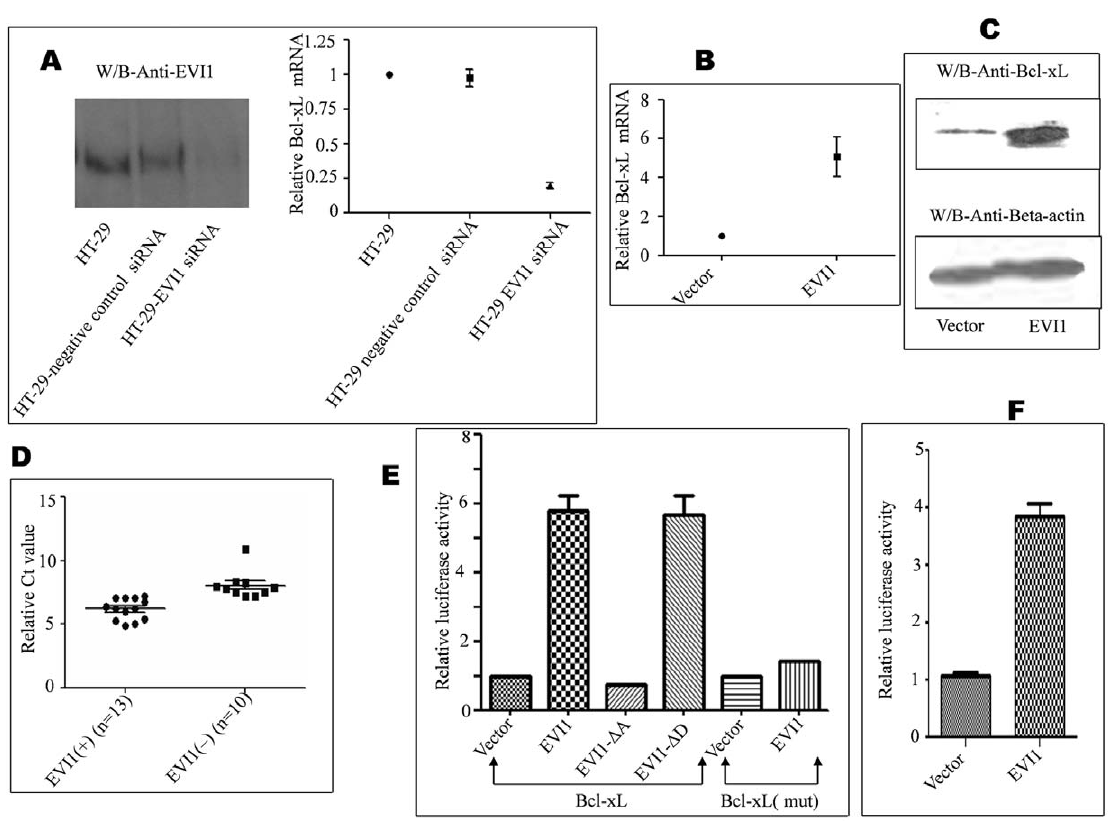
Figure 2. EVI1 induces Bcl-xL promoter trans-activity. A. HT-29 cell line was transfected with EVI1 siRNA and its negative control. After 24 h of transfection total RNA was isolated by TRIzol reagent (Invitrogen). Complementary DNA (cDNA) was prepared using oligodT (Fermentas, Germany) and subsequently RQ-PCR was performed with primers Bcl-xL-F-GCCACTTACCTGAATGACCAC, Bcl-xL-R-TGGATGGTCAGTGTCTGGT with SYBR green gold real time master mix (Eurogentec, Belgium). b -actin primers were used on the same sample for normalization. Bcl-xL level went down by 5.02 fold for siRNA transfected cells as compared to normal cells (p value=0.0141). The left panel showed the expression of EVI1 protein level. siRNA negative control neither showed any change in Bcl-xL mRNA level nor in EVI1 protein level as compared to only HT-29 cells. B. Bcl-xL mRNA was up regulated in EVI1 transfected cells. 293T cells transfected with only empty vector or EVI1 were processed as described above. The EVI1-positive cells showed 5.07 fold more Bcl-xL expression in comparison to normalized vector control (p value=0.047). C. Total protein was isolated from 293T cells transfected with only vector or with EVI1 and checked for BCL-XL protein level by standard Western blotting by using anti-Bcl-xL antibody (Imgenex India Pvt. Ltd). D. EVI1 positive (n=13) and negative cases (n=10) of CML patients were checked for Bcl-xL mRNA by RQ-PCR as described above. The EVI1 positive cases showed an up regulation of Bcl-xL compared to EVI1 negative cases. (P value=0.0001). E. 293T cell line was transfected with either empty vector or EVI1 along with the pGL2-Bcl-xL promoter or pGL2 Bcl-xL (mut) and renilla luciferase (internal control). Twenty four hours later the cells were lysed and luciferase activity was measured using the luminometer (GLOMAX 20/20, Promega). EVI1 up regulated the Bcl-xL promoter activity by 5.81 fold and not the mutated promoter. Also EVI1- D D up regulated the wild type promoter by 5.68 fold and not EVI1- D A. The results were expressed as mean 6 s.e. of triplicate experiments, which are representative of three different assays (p value , 0.0001). F. NIH3T3 cell line was transfected with either empty vector or EVI1 along with the pGL2-Bcl-xL promoter and renilla luciferase (internal control). Luciferase activity was measured as described above. EVI1 up regulated the Bcl-xL promoter activity by 3.6 fold in NIH3T3 cells (p value=0.0066).